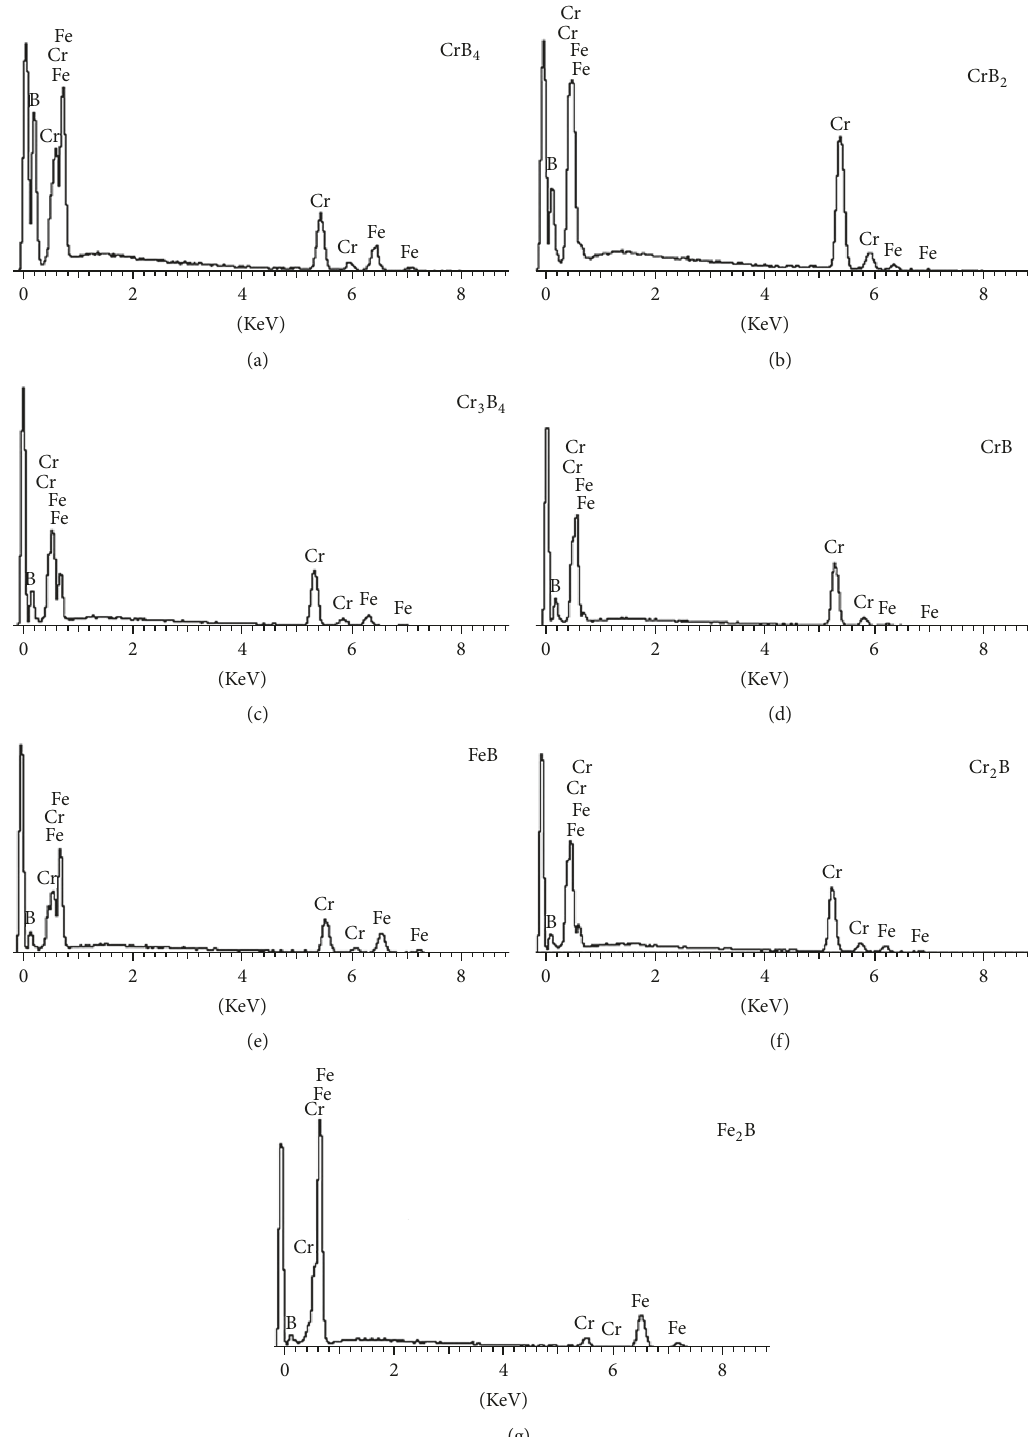
Figure 2: EDX spectrum of the CrB 4 in 33Fe-62B-5Cr alloy (a); CrB 2 in 17Fe-65B-18Cr alloy (b); Cr 3 B 4 in 8Fe-62B-30Cr alloy (c); CrB boride in 15Fe-40B-45Cr alloy (d); FeB boride in 50Fe-40B-10Cr alloy (e); Cr 2 B boride in 15Fe-40B-45Cr alloy (f); Fe 2 B boride in 50Fe-40B-10Cr alloy